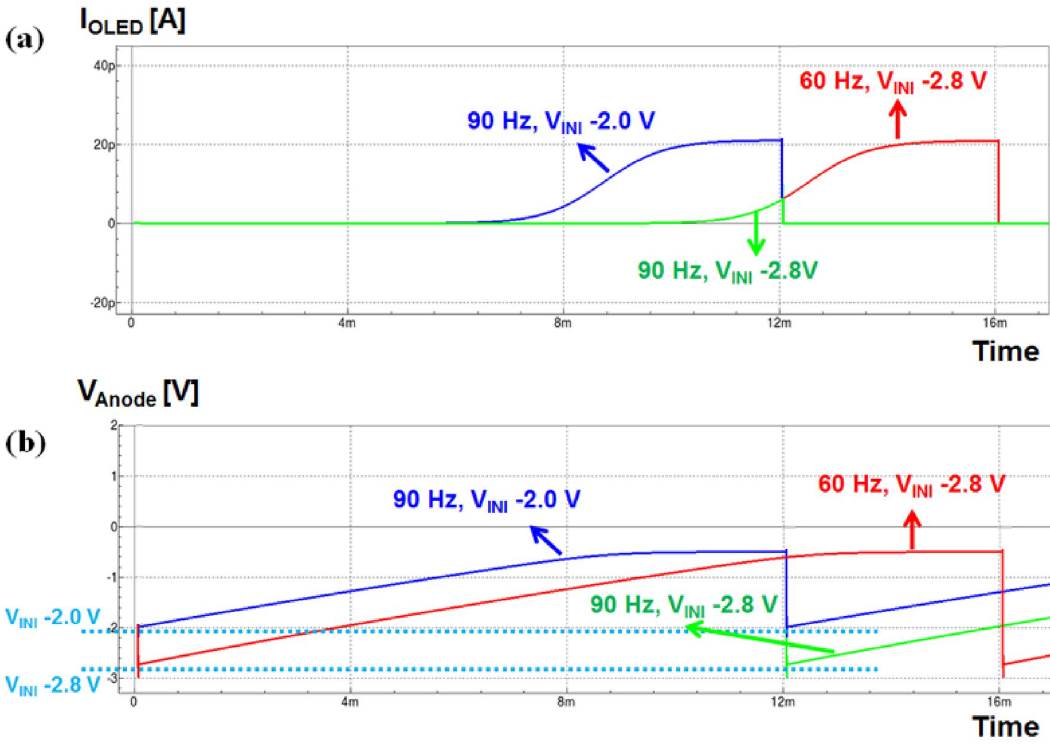
Figure 5. Simulation results for ( a ) OLED pixel current and ( b ) anode voltage in various V INI at 60 and 90 Hz conditions.